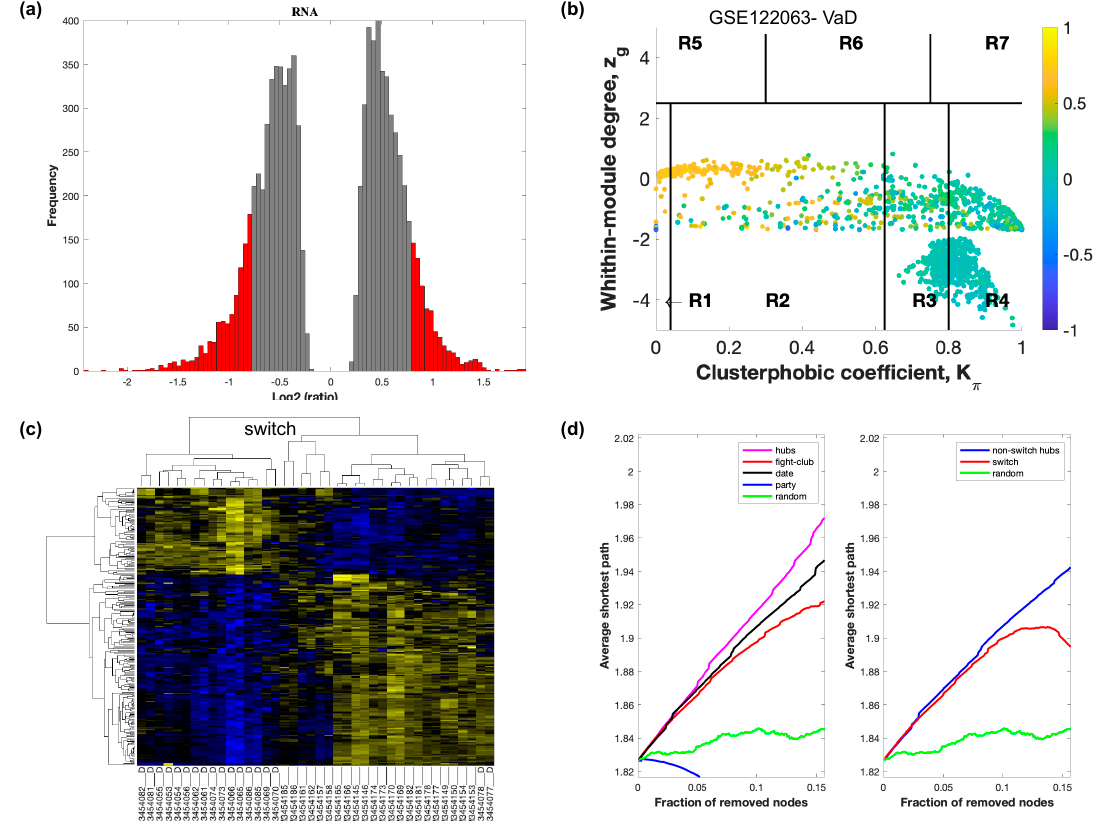
Figure 3. SWIM analysis of the frontal cortex of VaD subjects in GSE122063. ( a ) Distribution of log2 fold change values where the red bars are selected for further analysis. ( b ) Heat Cartography Map with nodes colored by their average Pearson Correlation Coe ffi cient. Region R4 represents the switch genes. ( c ) Dendrogram and heat map for switch genes. The su ffi x _D indicates the sample came from the diseased cohort. ( d ) Robustness of the correlation